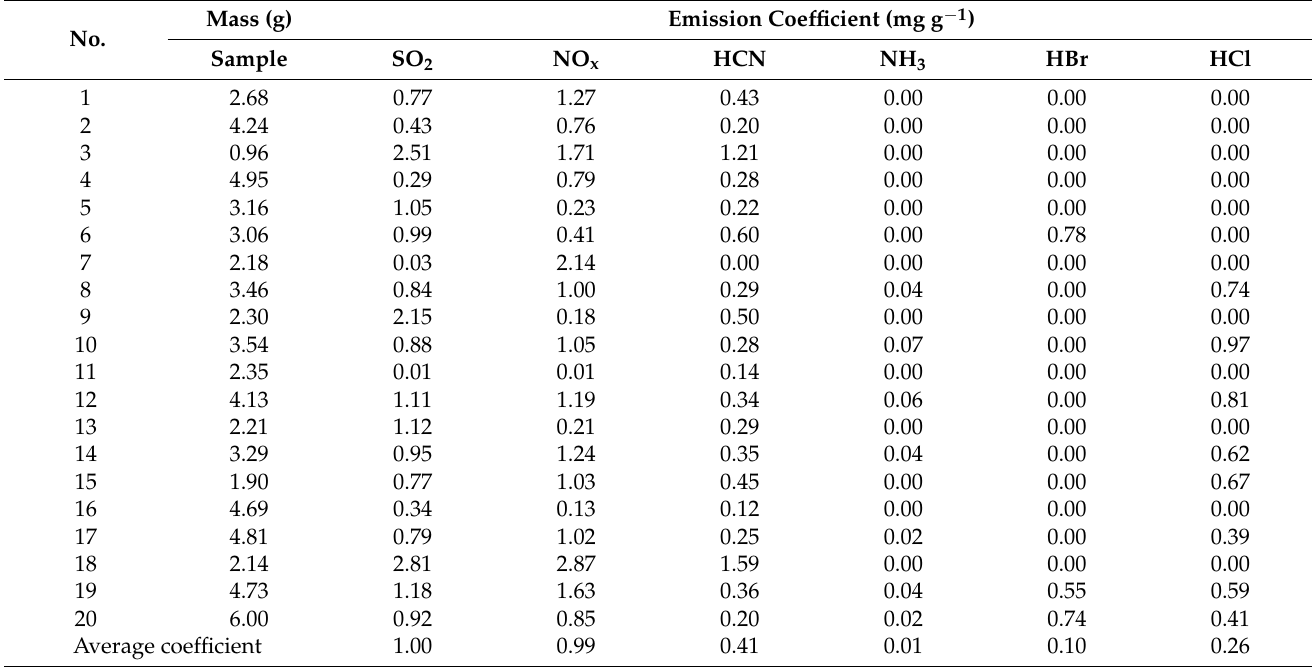
Table 7. The emission factor of SO 2 , NO x , HCN, NH 3 , HBr and HCl in the exhaust gases obtained during thermal treatment of waste mobile phones in a fluidised